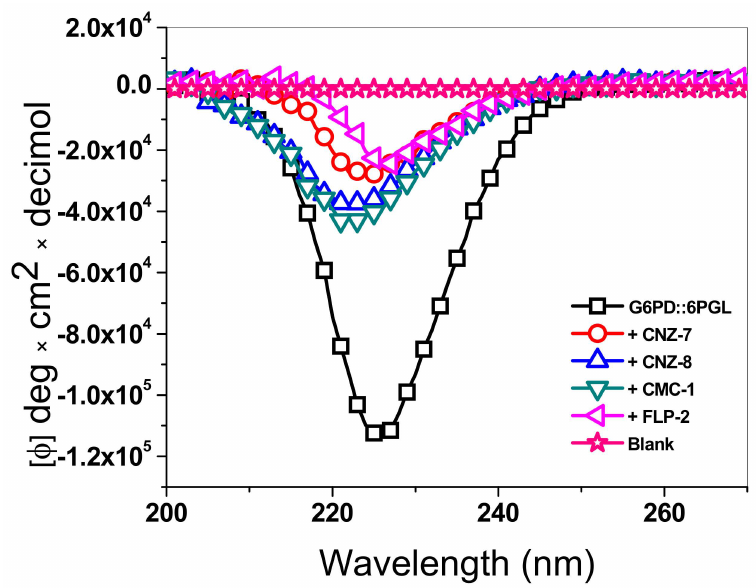
Figure 5. Far-UV circular dichroism (CD) spectra of GlG6PD::6PGL. The selected compounds at the IC 50 concentration of CNZ-7, CNZ-8, CMC-1, and FLP-2 were incubated with 0.4 mg/mL of GlG6PD::6PGL protein for 2 h at 37 ◦ C before measurement. The spectra in the far-UV region from 200 to 260 nm were obtained. The experiment is representative of triplicate